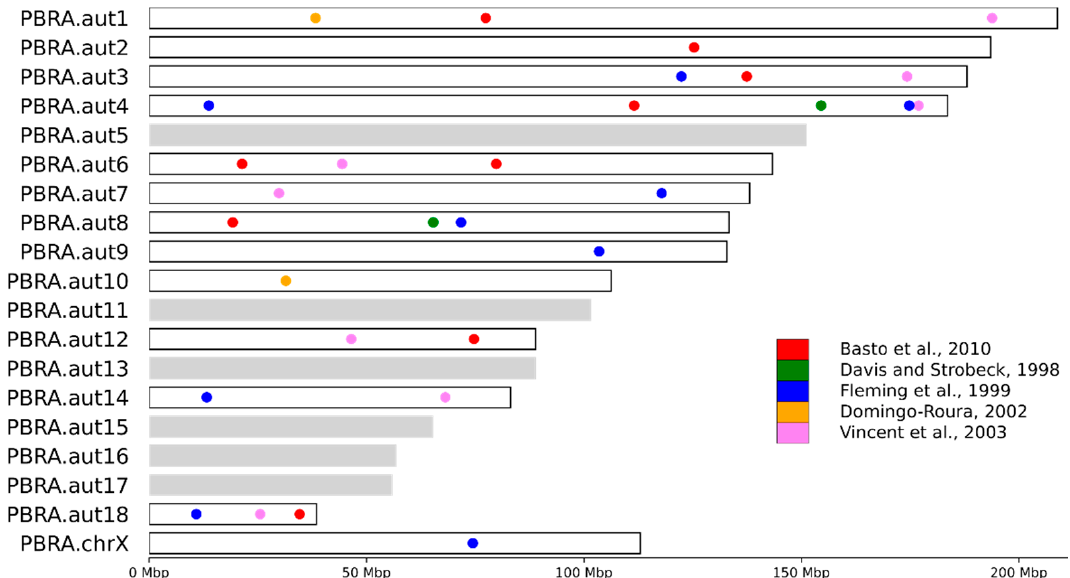
Figure 6. Localization of in silico amplified STR markers on C-scaffolds in the giant otter ( Pteronura brasiliensis ) genome (Basto et al., 2010; Davis and Strobeck., 1998; Fleming et al., 1999; Domingo-Roura, 2002; Vincent et al., 2003) [40–43,47]. The color of the dots indicates the source publication where marker was developed, the light grey bars show unlabeled (no markers) C-scaffolds. Similar localization maps for other mustelids in this study are shown in Supplementary Figures S1–S5.